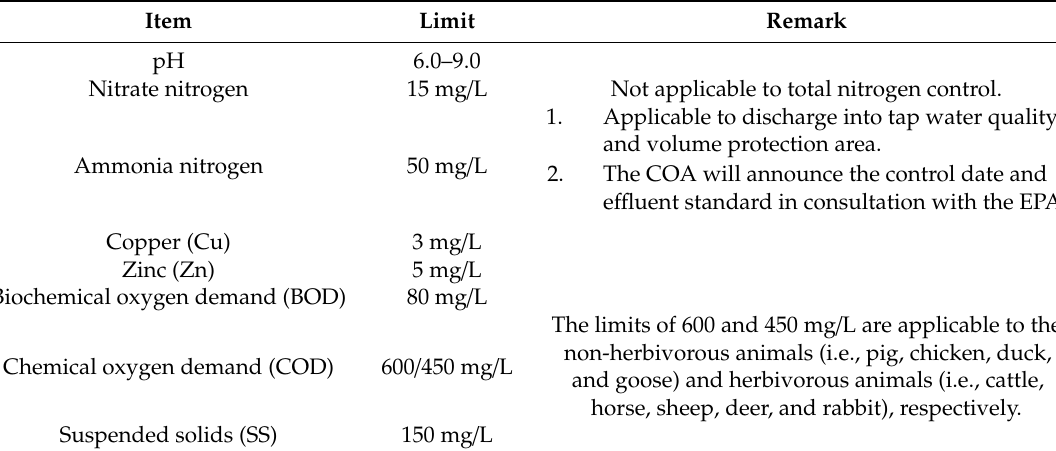
Table 5. Main e ffl uent standards for livestock / poultry-raising